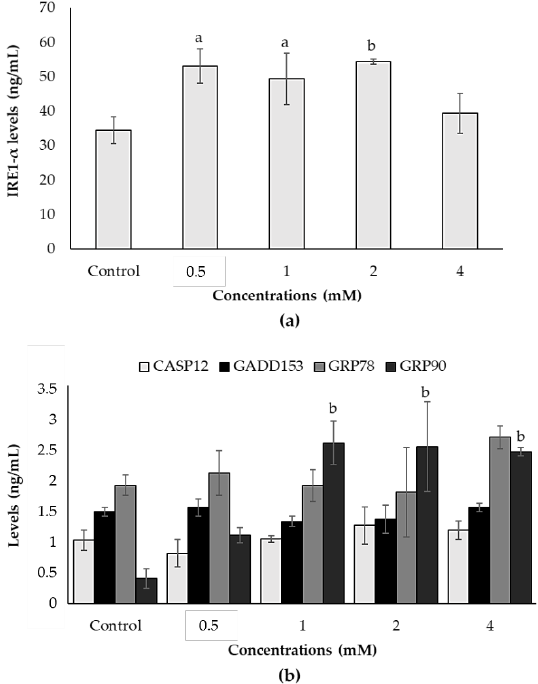
Figure 4. Effects of ACE on endoplasmic reticulum stress in SH-SY5Y cells after 24 h of treatment. ( a ) IRE1- α and ( b ) GRP90 levels were significantly increased with ACE treatment. Data are presented as mean ± SD; and statistically significant changes are indicated as a: p < 0.05 and b: p <